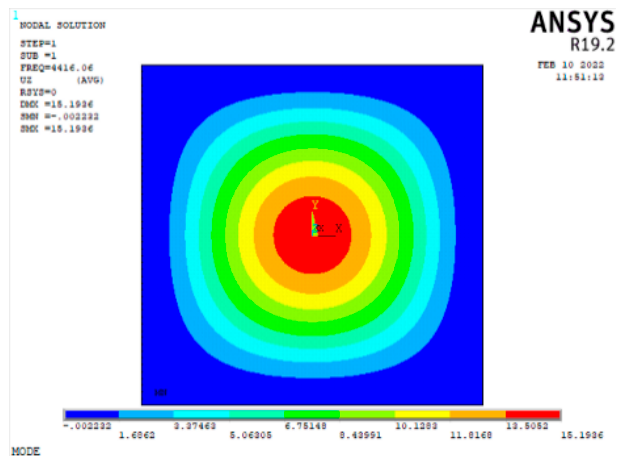
Figure 4. Cloud image of the first-order vibration mode of the iced aluminum alloy plate. For analyzing mesh sensitivity and accuracy, in this paper, modal analyses for an iced aluminum alloy plate were conducted. The iced aluminum alloy plate was meshed by a mapped method. The simulation results are shown in Figure 5.